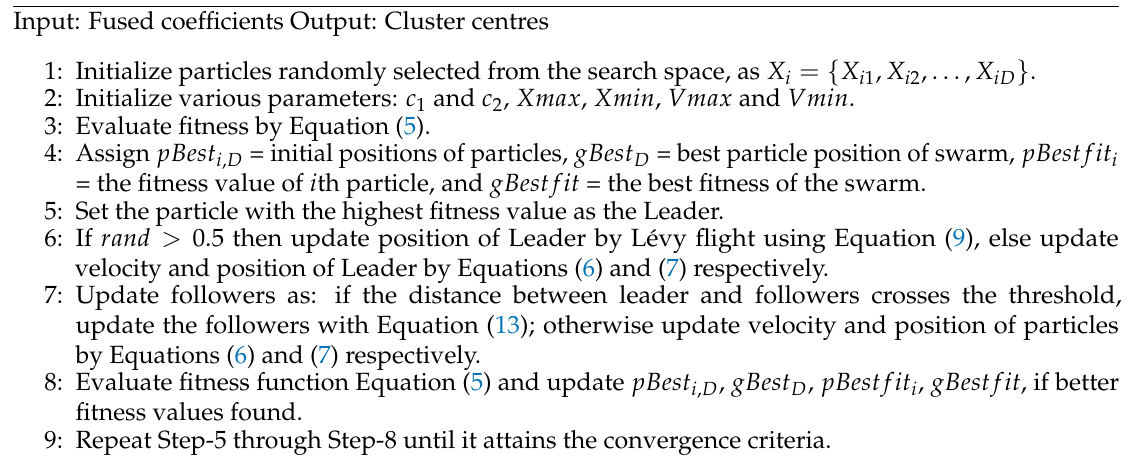
Algorithm 2 Leader Intelligence Particle Swarm